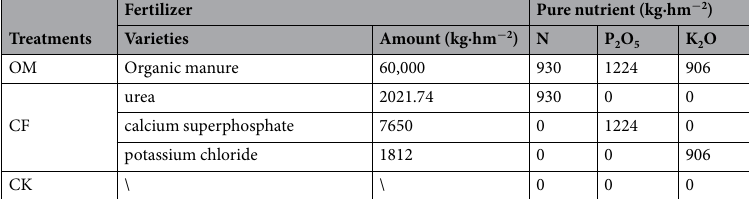
Table 1. Varieties and amounts of fertilizer each year under the different